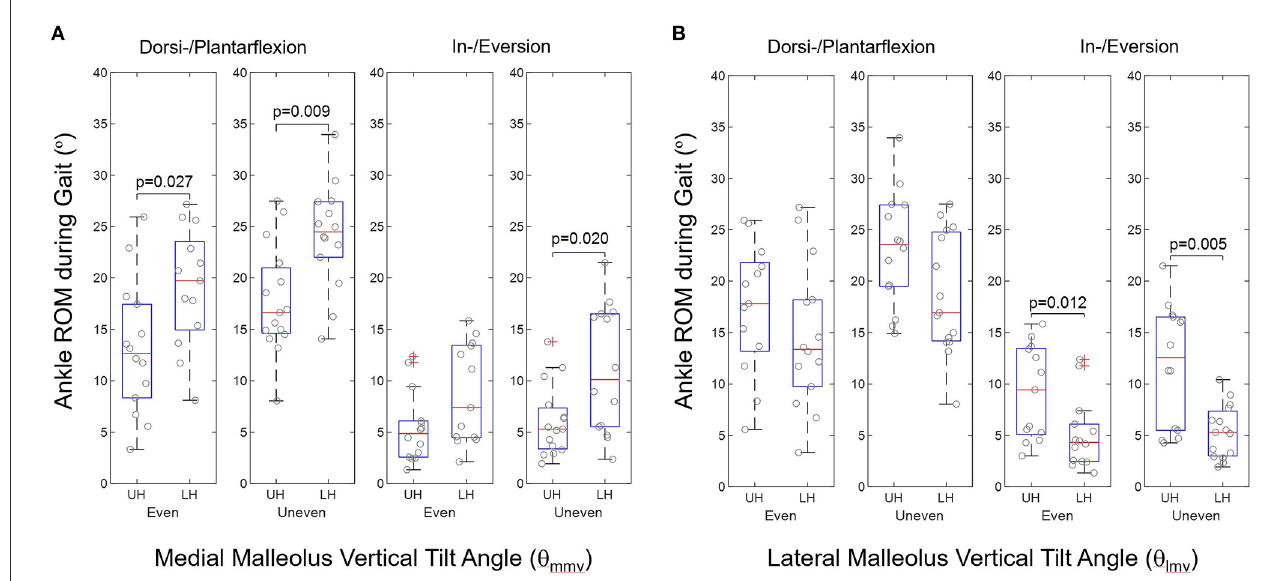
FIGURE2 Group comparison of ankle ROM during walking in terms of upper half (UH) and lower half (LH) in (A) medial malleolus vertical tilt angle ( θ mmv ) and (B) lateral malleolus vertical tilt angle ( θ lmv ) according to ankle geometric measurements in stroke ( n = 30).